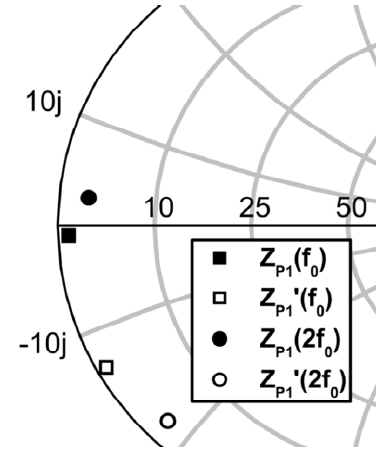
Figure 9. Fundamental and second harmonic impedances before and after the bond